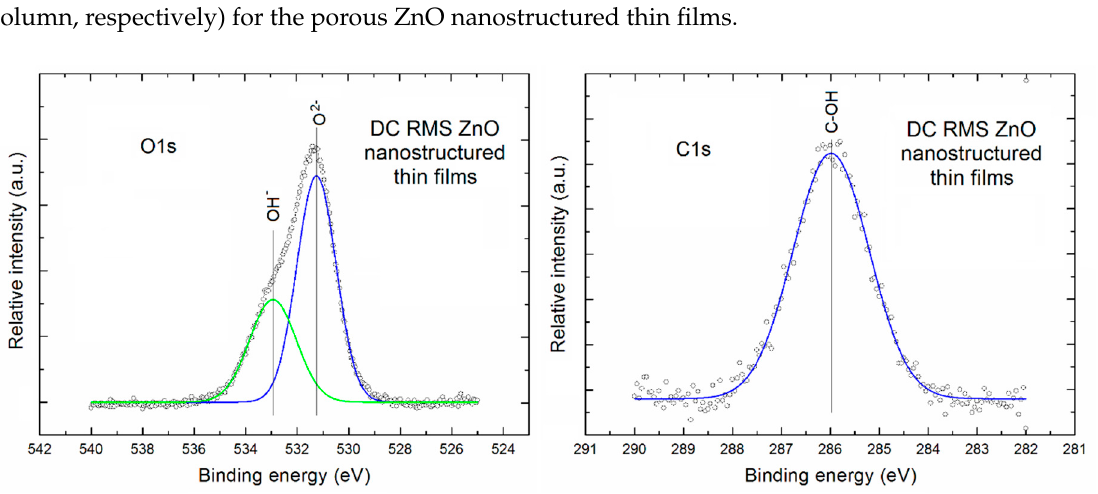
Figure 3. The XPS O1s and C1s lines after deconvolution using Gauss fitting procedure for the porous ZnO nanostructured thin films.